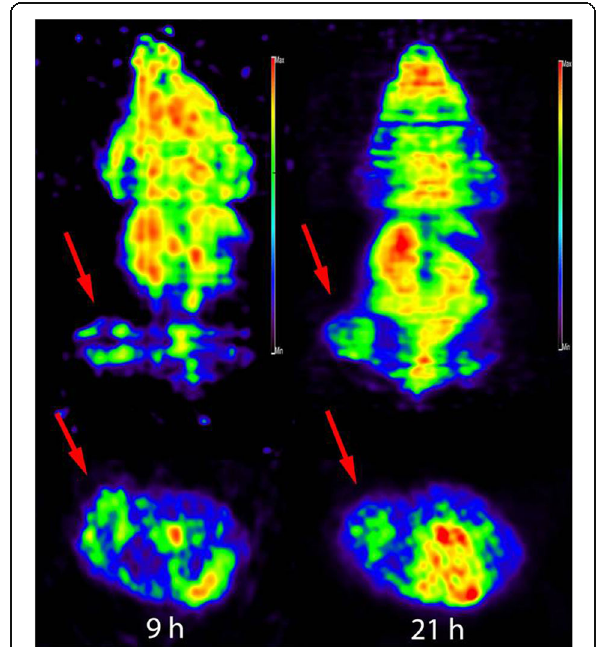
Fig. 2 Biodistribution of 64 Cu-AGuIX in nude mice bearing HepG2 tumors. Radioactivity uptake in each tissue/organ were presented in %ID/g at 9, 21, and 40 h after intraperitoneal injection of 64 Cu-AGuIX (mean ± SD, n = 3)